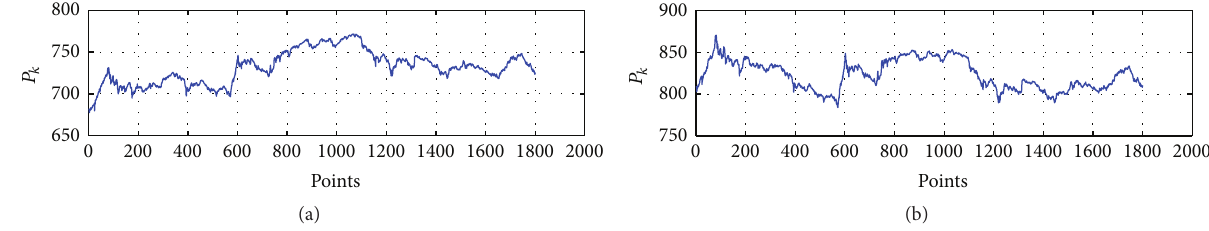
Figure 4: The observation data ((a): Shanghai composite index, (b): Shenzhen component index).